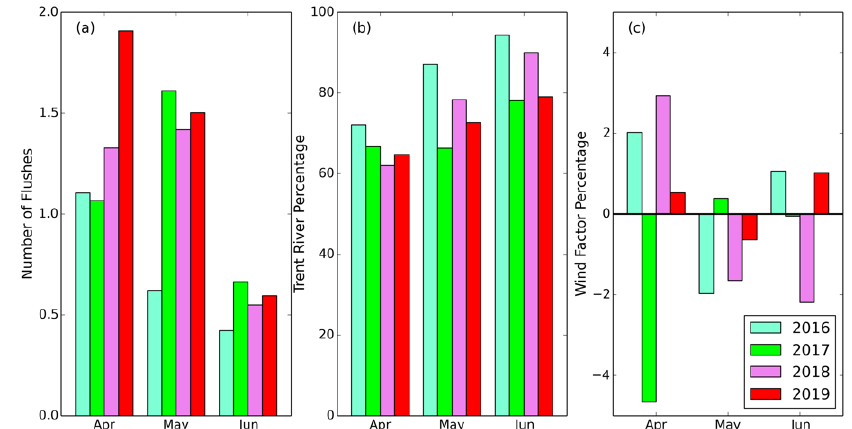
Figure 6. ( a ) Number of flushes, ( b ) percentage of the number of flushes due to the Trent River, and ( c ) percentage flush due to the wind, in April, May and June for each year.